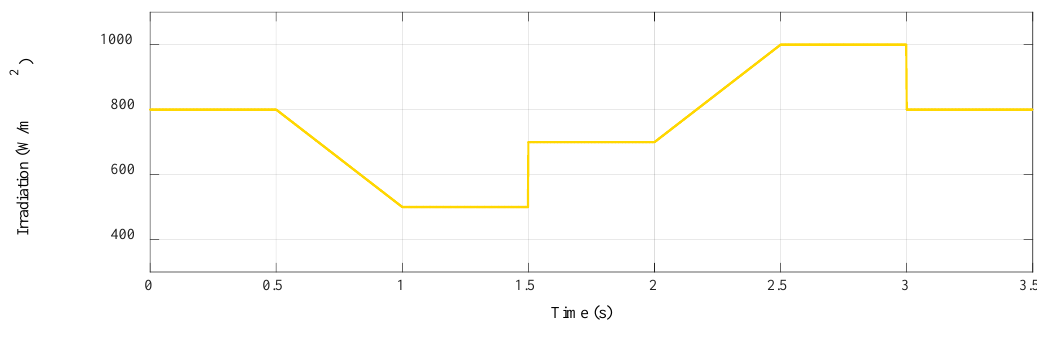
Figure 10. Solar irradiation profile.